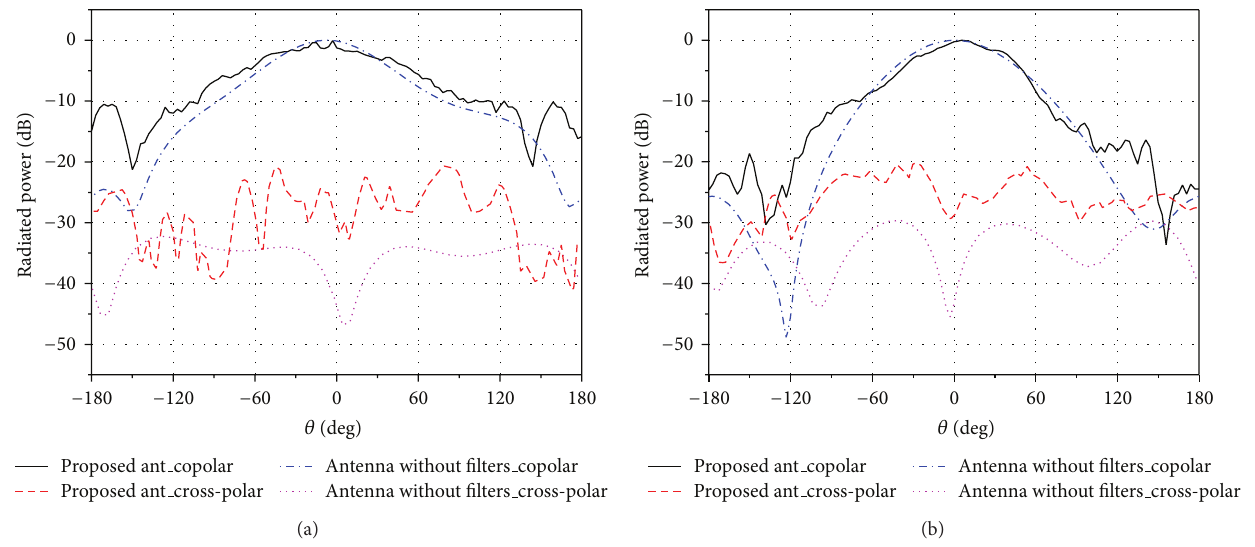
Figure 8: Measured radiation pattern for port 2 (2.5 GHz). (a) E-plane ( 𝑥 - 𝑧 plane), (b) H-plane ( 𝑦 - 𝑧